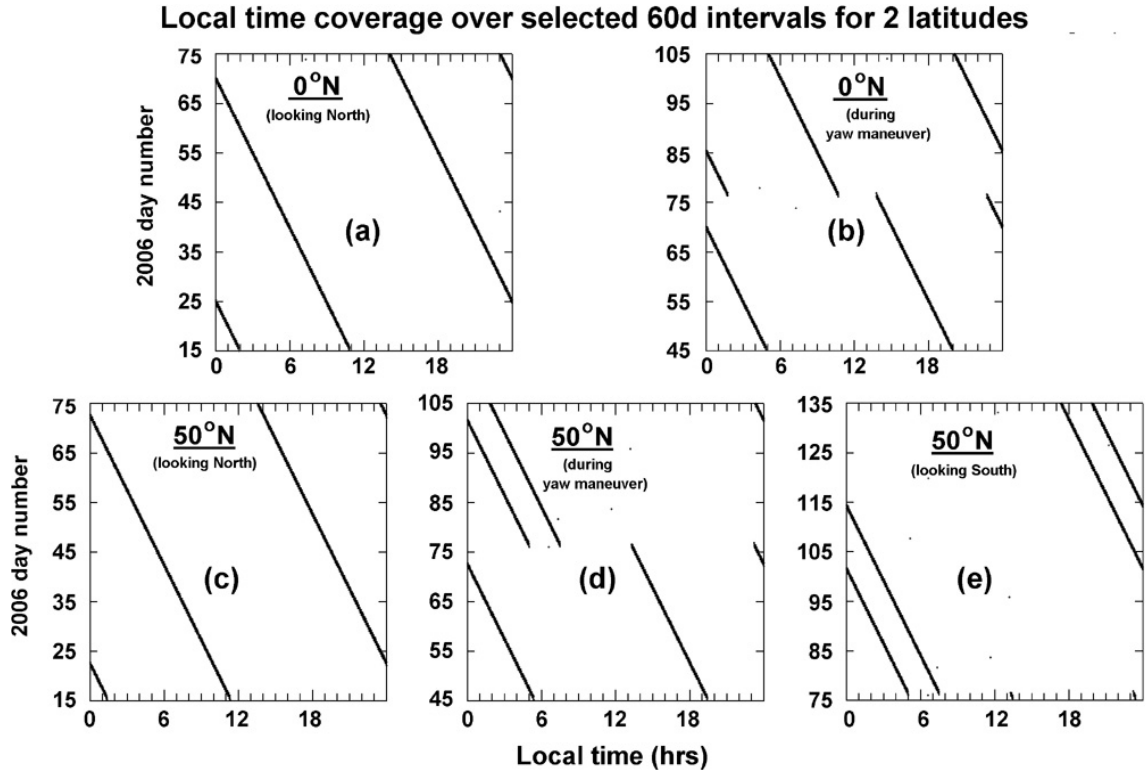
Fig. 2. Local time coverage for 60d intervals with and without yaw maneuver at 0 ◦ and 50 ◦